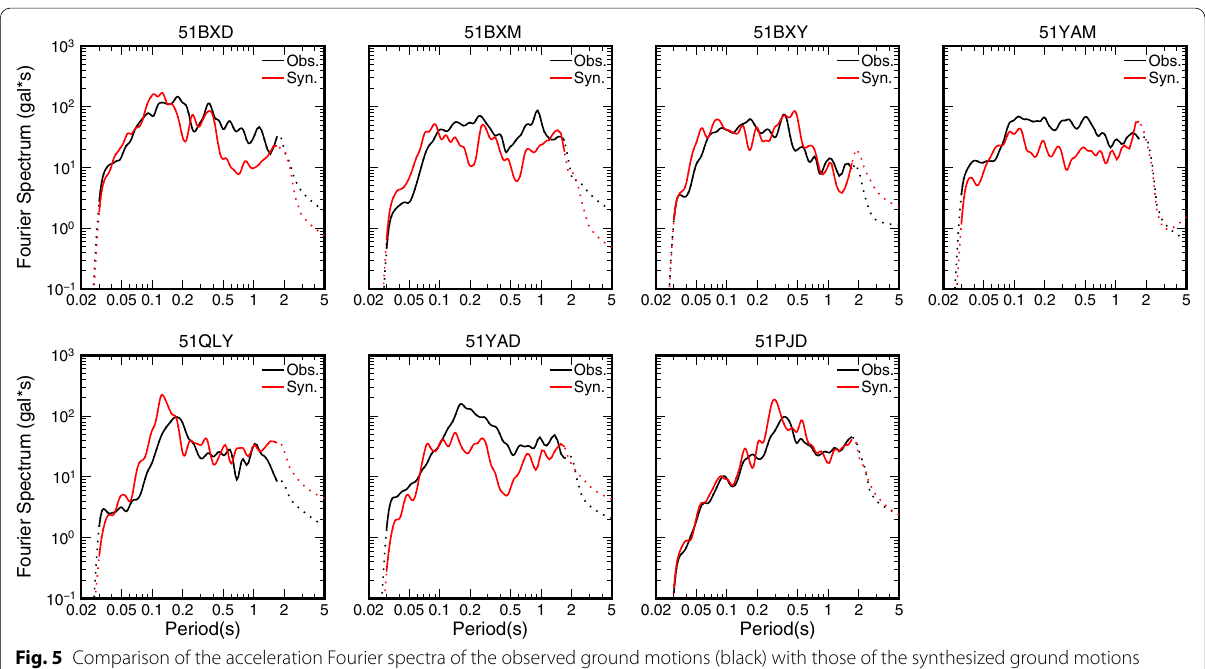
Fig. 5 Comparison of the acceleration Fourier spectra of the observed ground motions (black) with those of the synthesized ground motions (red). The acceleration Fourier spectra are the vector summation in two horizontal components at stations except 51QLY, of which the acceleration Fourier spectrum is evaluated from the ground motions only in the NS component. The Fourier spectra are smoothed by use of a logarithmic window function (Konno and Omachi 1998)